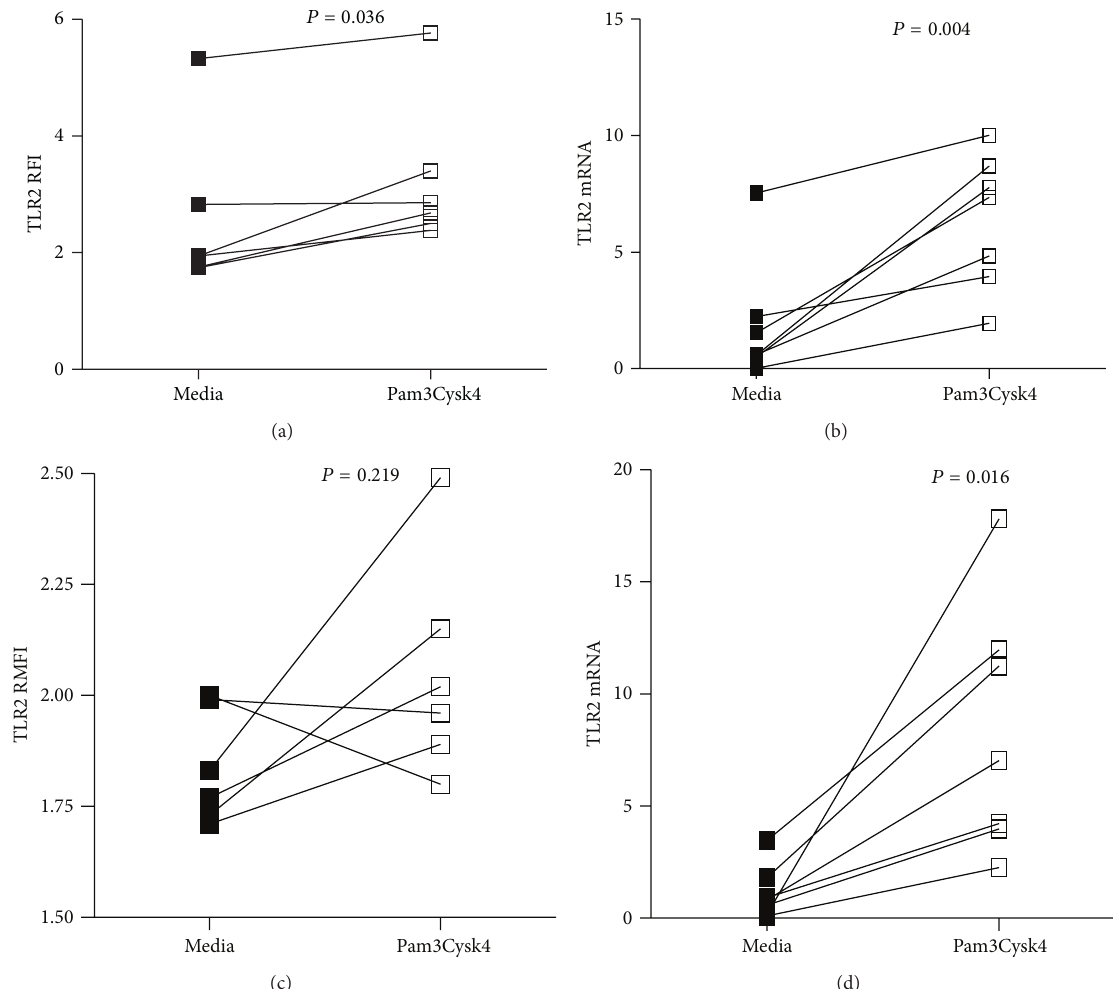
Figure 5: TLR2 surface and gene expression following TLR2 stimulation using Pam3CysK4: (a) mononuclear cells TLR2 surface expression, (b) mononuclear cells TLR2 gene expression, (c) granulocyte TLR2 surface expression, and (d) granulocyte TLR2 gene